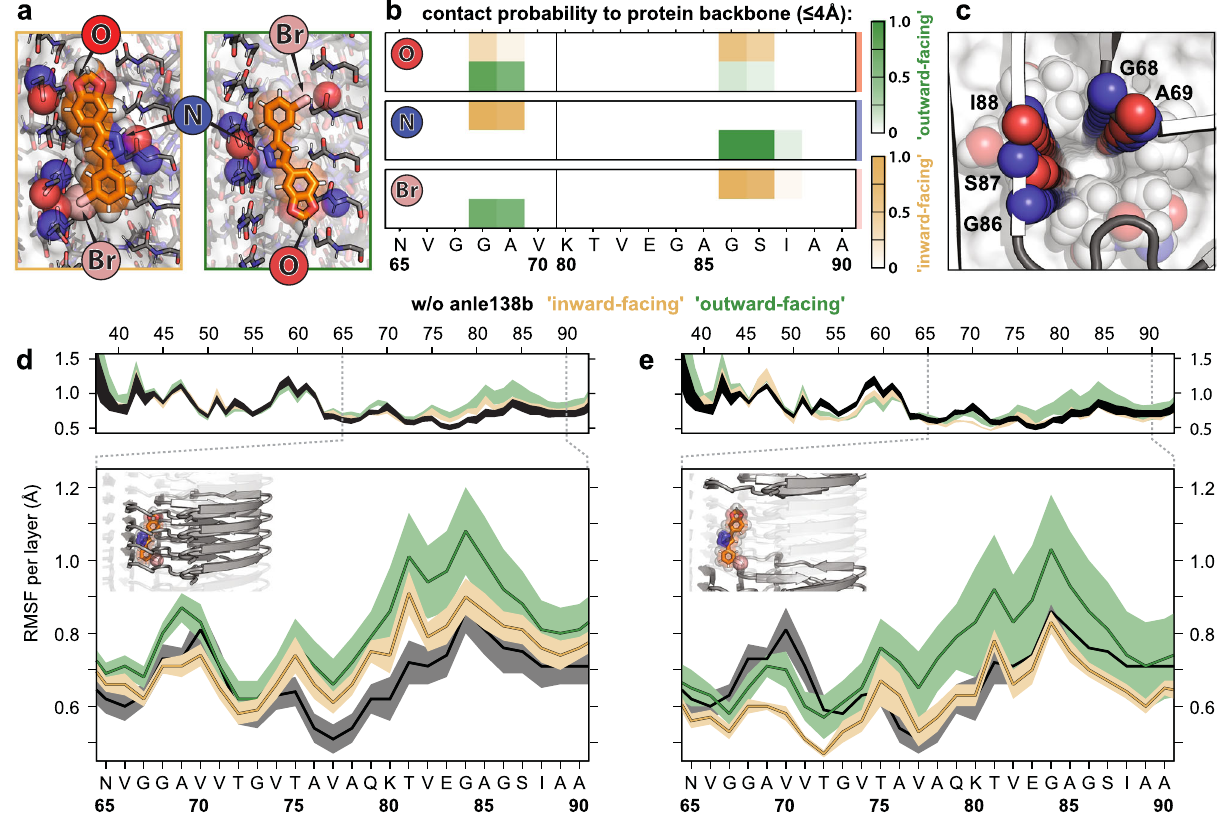
proto fi lament (shown without anle138b for clarity). Prominent contact sites in the backbone scaffold are represented by circles (colors as in a ). d , e Average root mean squared fl uctuations (RMSF) for d the four consecutive β -strands in contact with anle138b and e β -strands without close polar interactions. Average RMSF withoutanle138bpresentshownforcomparison(blacklines). β -strandsofthe fi bril ends were not considered. Data are presented as mean values ± SEM (depicted by shading). Source data are provided as a Source Data fi